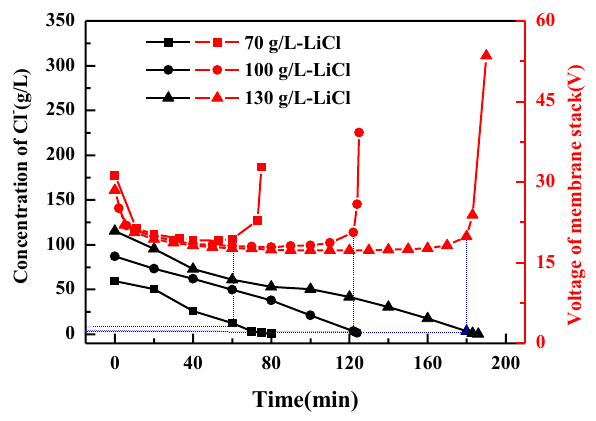
Fig. 3 Acid and base concentration curves at different initial feed